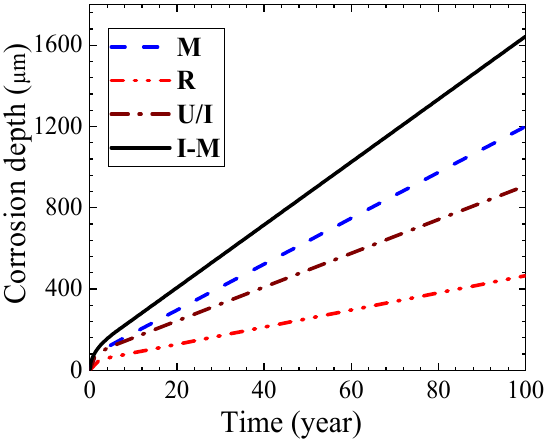
Figure 8. Long-term corrosion depth prediction curve for carbon steel in Ningbo.